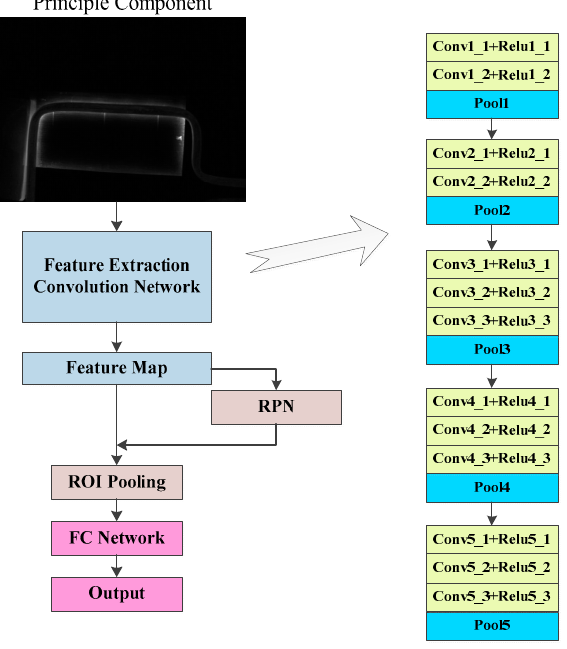
Figure 3. Structure of Faster ‐ RCNN.